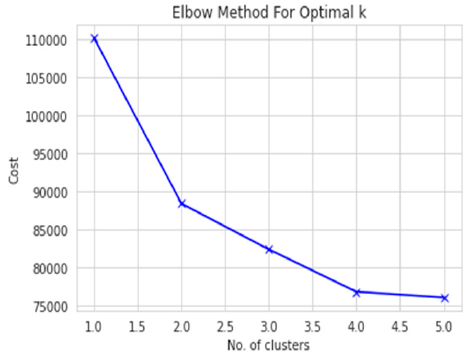
Figure 3. Male dataset.